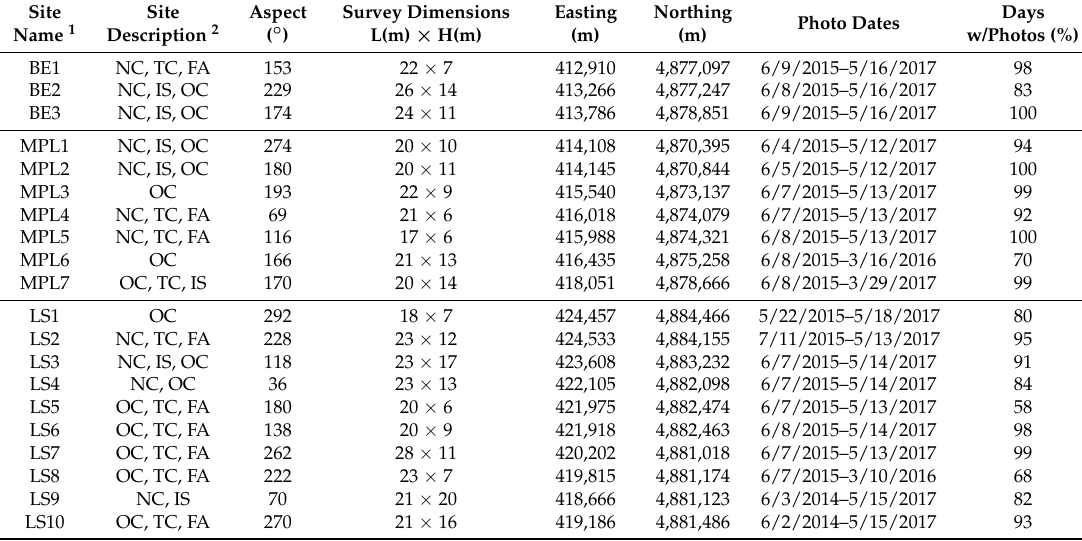
Table A1. Time lapse camera site information. Easting and Northing coordinates reference datum NAD83, and projection UTM Zone